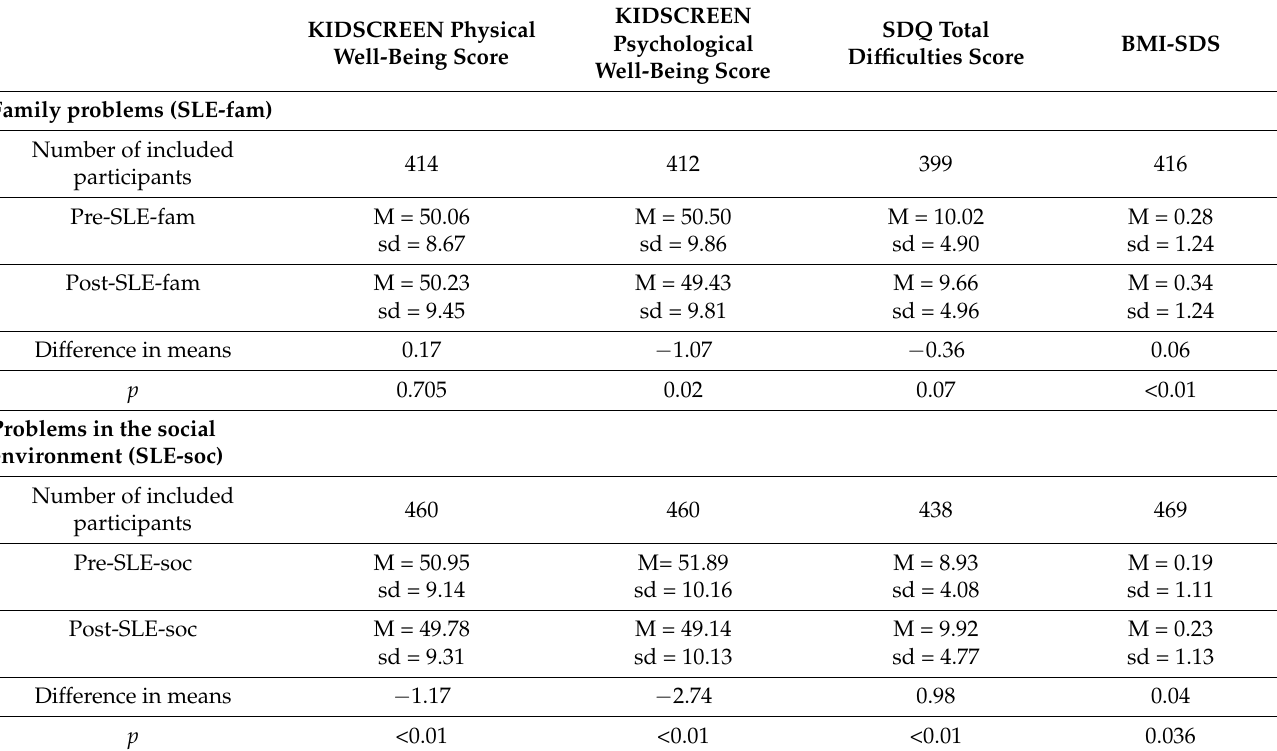
Table 2. Changes in health parameters from before to after an SLE had